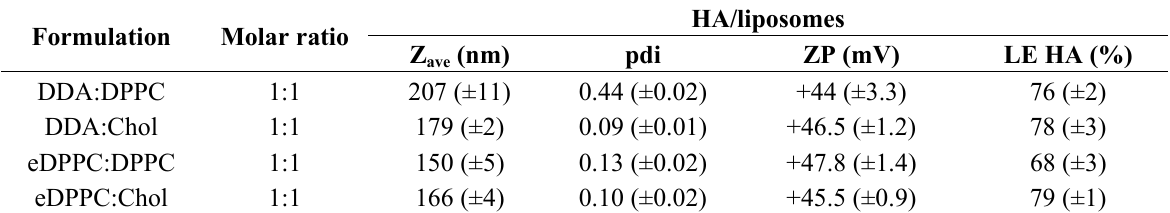
Table 2. Physicochemical characteristics of cholesterol- and DPPC-based cationic liposomes after mixing with